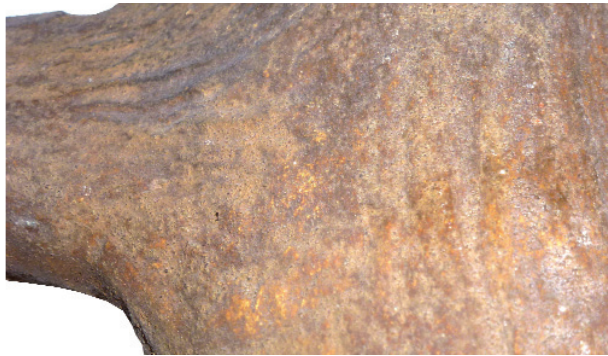
Figure 1. Detail of a deer horn on which sand was glued to increase the realism (Paleontological Museum of Rome